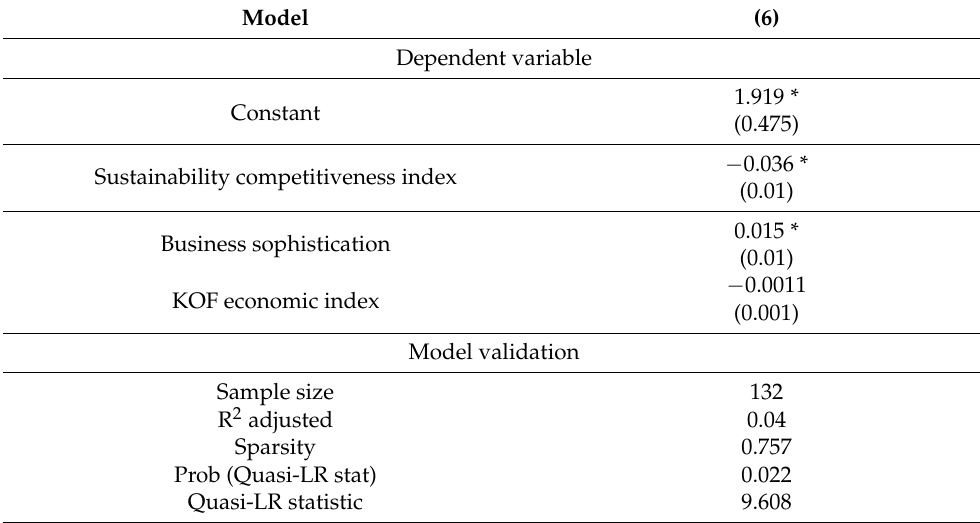
Table 5. Quantile regression estimated models (2nd